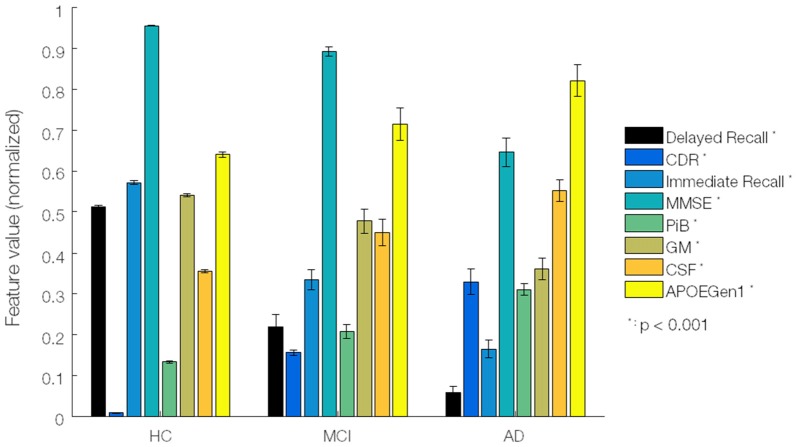
Significant data features ranked by ANOVA test. A total of 8 out of 33 features were identified by ANOVA test from 58 Alzheimer’s disease (AD), 108 mild cognitive impairment (MCI) and 120 healthy elderly (HE) samples. Features/biomarkers were ranked based on their p-values. The biomarkers include clinical dementia ratio (CDR), Mini-Mental State Exam (MMSE), delayed memory recall (DeRecall), immediate memory recall (Immediate Recall), gray matter (GM), average intensity of PiB, cerebrospinal fluid (CSF), and Apolipoprotein E (ApoE) genotype 1. Error bars represent a standard error.